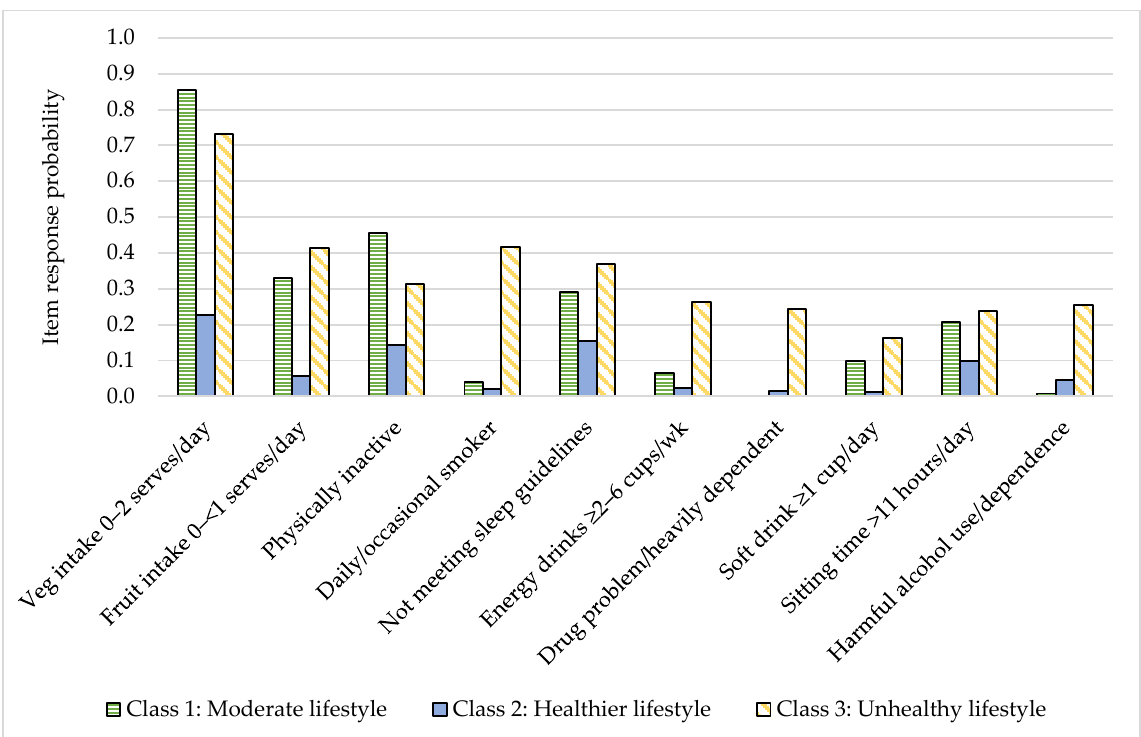
Figure 2. Item response probability for lowest risk category of each health behavior by health behavior class.